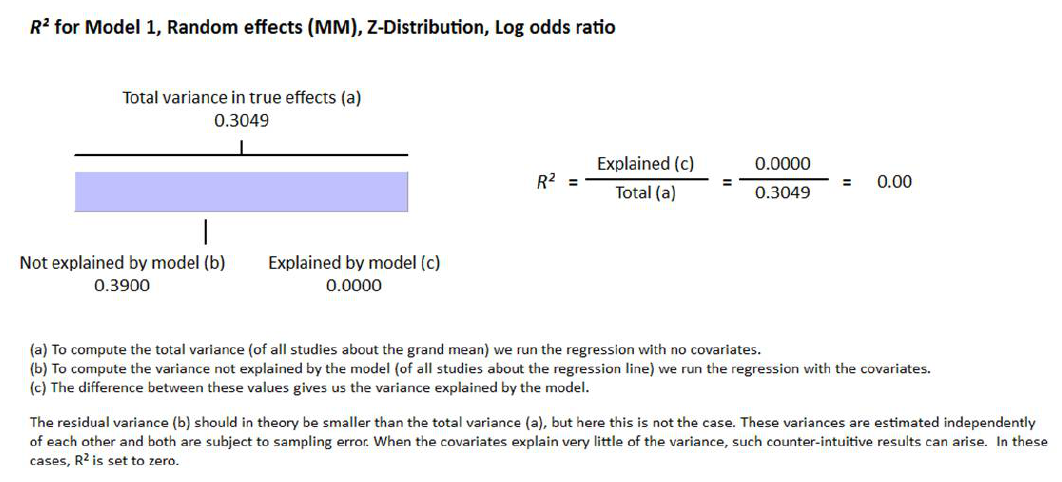
Figure 3. Meta regression analysis for the moderator latitude, R-Squared represents the contribution of latitude to the variability of correlation.